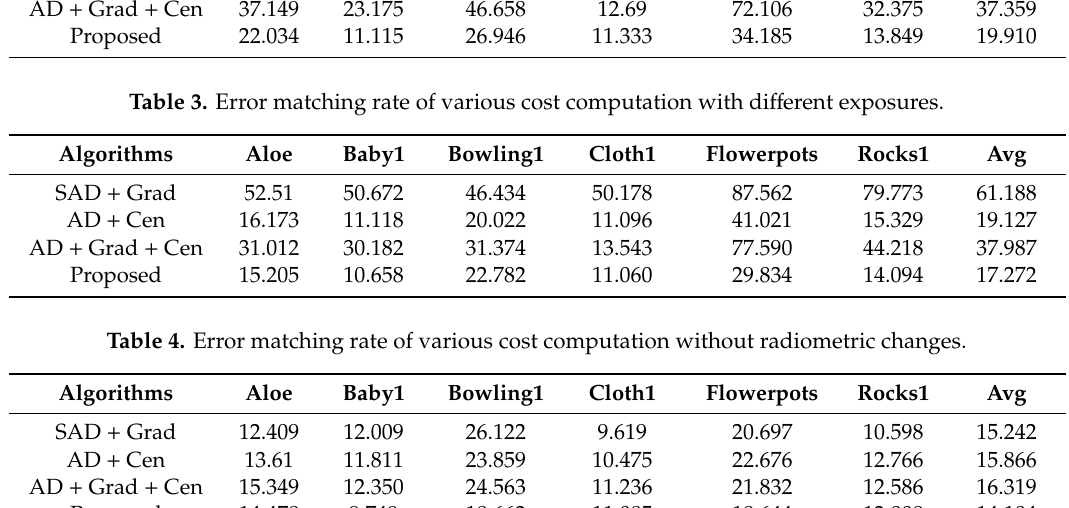
19.910 Table 3. Error matching rate of various cost computation with different exposures. Algorithms